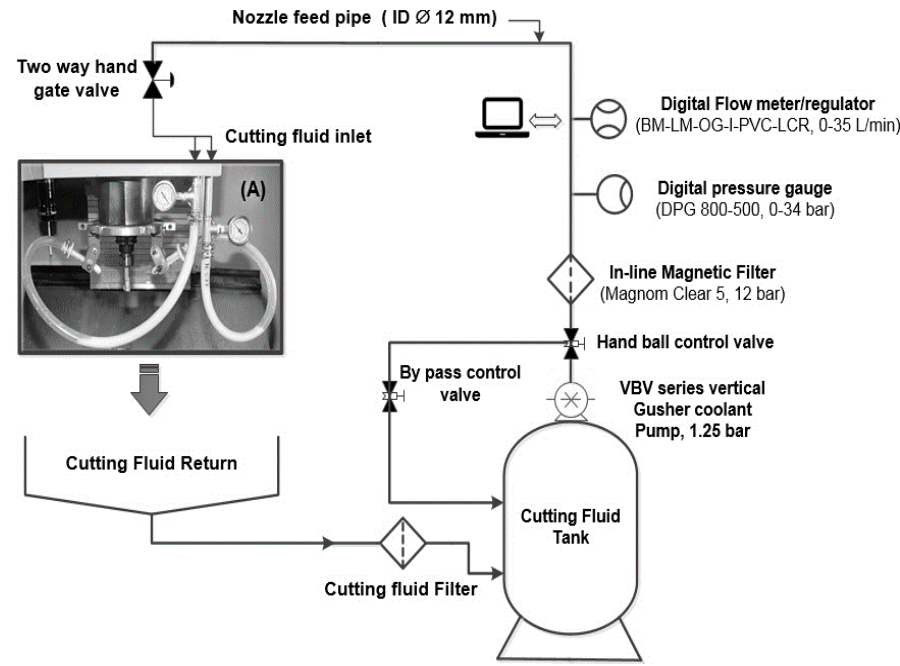
Figure 2. Configuration of the developed Cut-list supply system, data from [2].